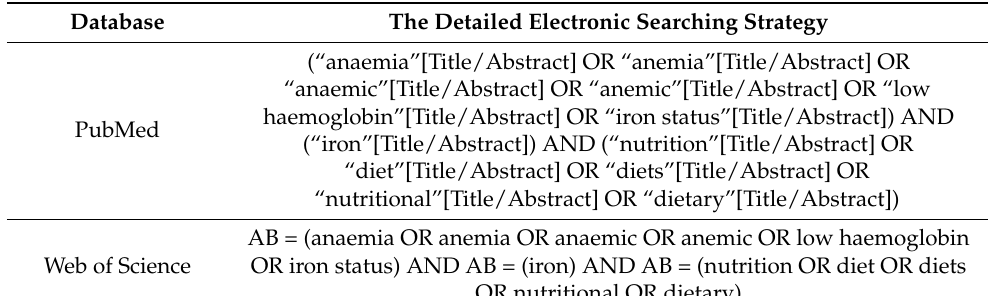
Table 2. The detailed electronic searching strategy for the databases of PubMed and Web of Science.